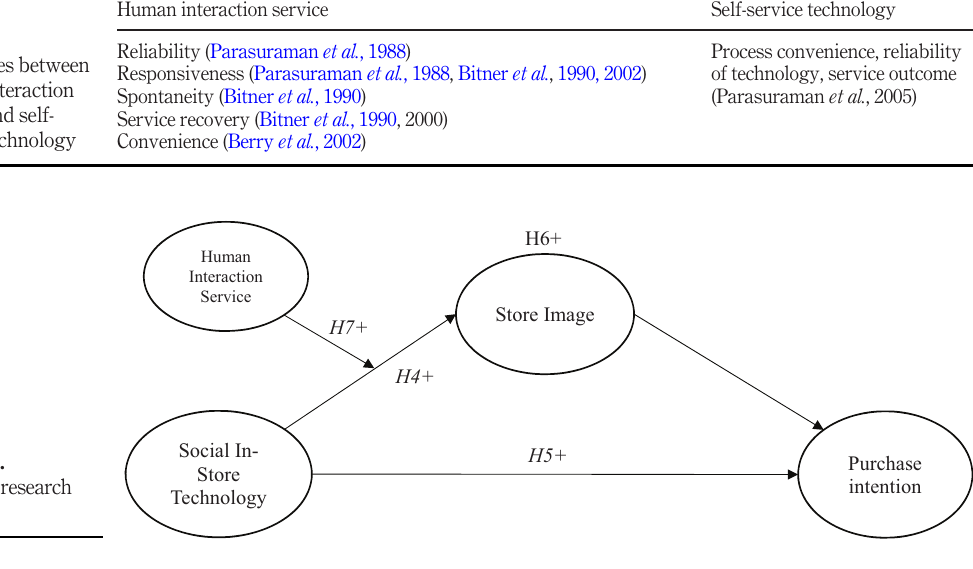
Human interaction service